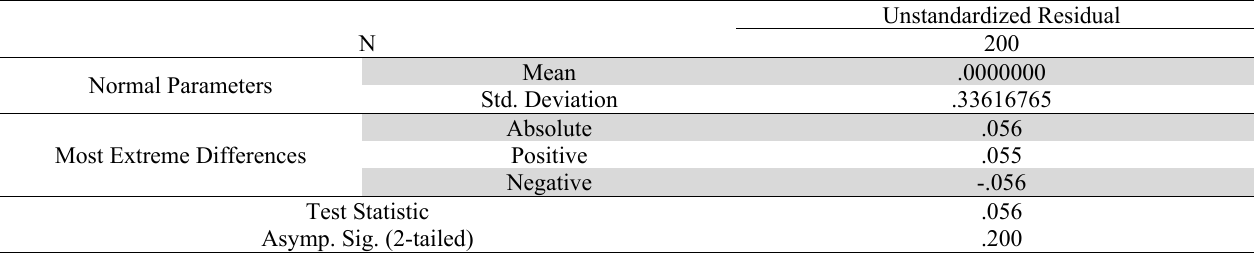
Unstandardized Residual